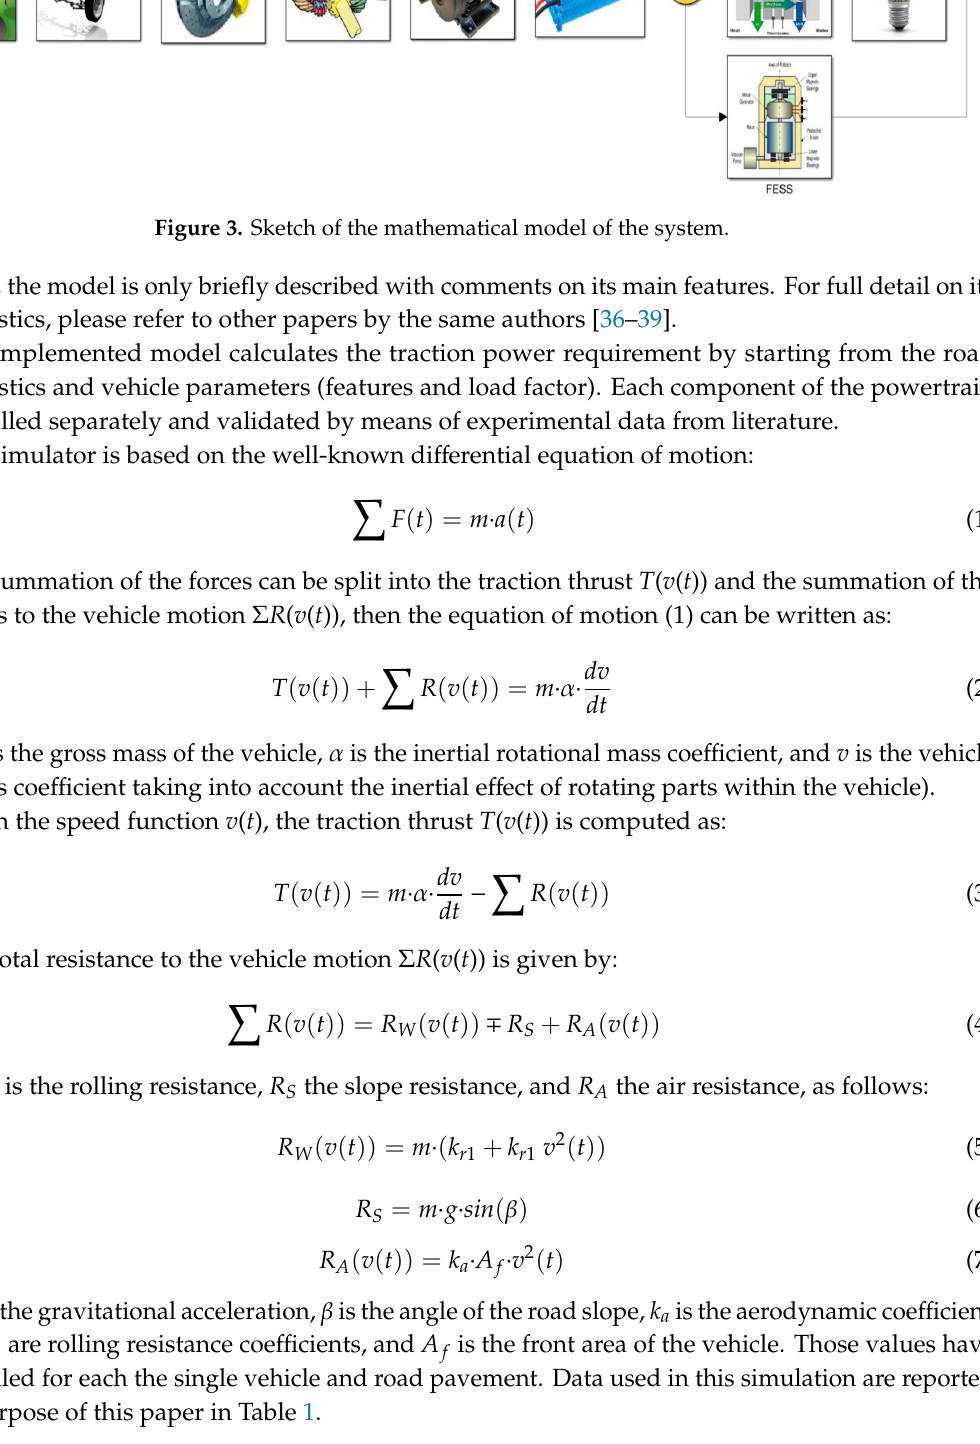
Table 1. Vehicle and power unit features.